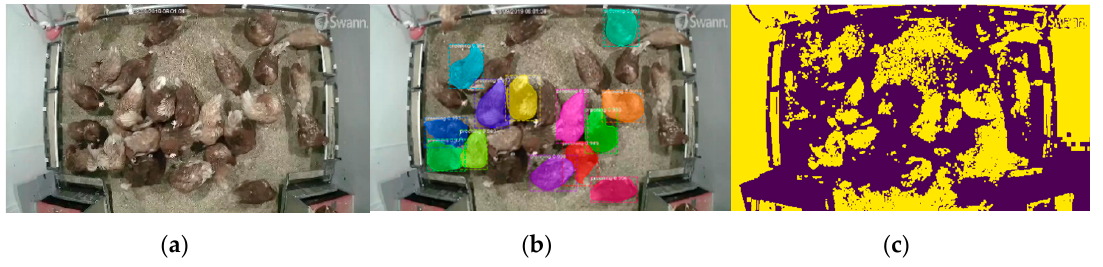
Figure 7. Sample detection. ( a ) Original image; ( b ) preening instance segmentation using the mask region-based convolution neural network detector; and ( c ) image segmentation using Otsu’s thresholding. Some preening birds in the Figure 7b are masked with different colors.